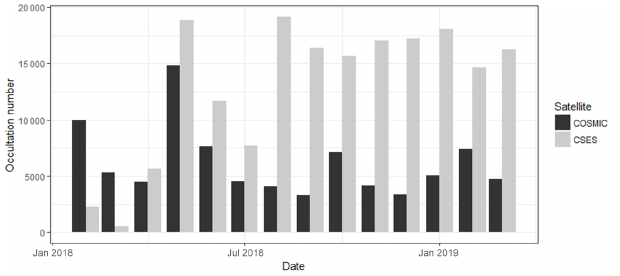
Figure 1. Occultation number per month from February 2018 to March 2019 for both CSES and